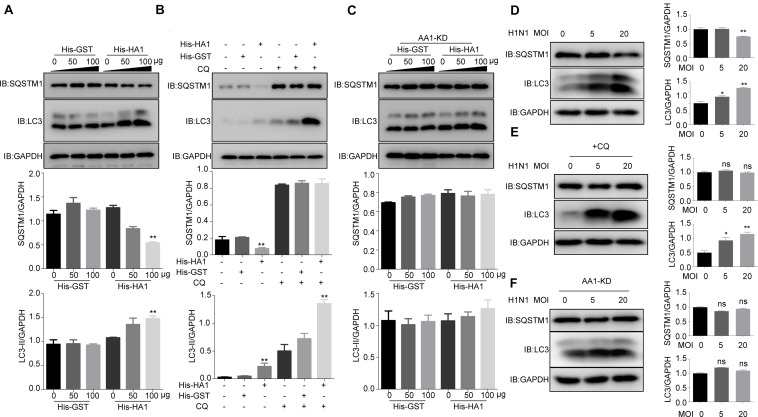
IAV HA1 induces autophagy through HSP90AA1. (A) Immunoblotting analysis of autophagy was analyzed; A549 cells were cultured in DMEM with 10% FBS in the presence of His-GST or His-HA1 protein as indicated for 2 h. (B) A549 cells treated with and without chloroquine for 2 h, then treated with His-GST or His-HA1. Immunoblotting analysis of autophagy flux was detected by using the indicated antibodies. (C) HSP90AA1-knockdown (AA1-KD) A549 cells were cultured in DMEM with 10% FBS in the presence of His-GST or His-HA1 protein as indicated for 2 h. Immunoblotting analysis was performed by using the indicated antibodies. (D) A549 cells were incubated with H1N1 at 4°C for 2 h (MOI = 5.0 or 20.0), and cell lysates were analyzed by Western blotting with the indicated antibodies. (E) A549 cells were treated with chloroquine for 2 h, then incubated with H1N1 at 4°C for 2 h. Immunoblotting analysis was performed by using the indicated antibodies. (F) HSP90AA1-knockdown (AA1-KD) A549 cells were incubated with H1N1 at 4°C for 2 h (MOI = 5.0 or 20.0), and cell lysates were analyzed by Western blotting with the indicated antibodies. Error bars: mean ± SD of three independent tests. Two-way ANOVA; *P < 0.05; **P < 0.01 compared with control.